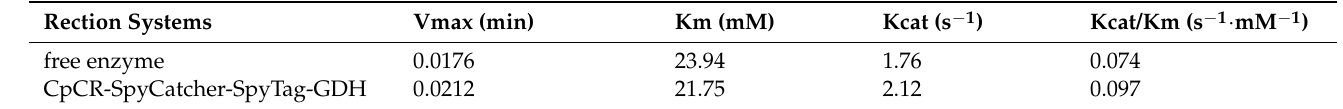
Table 8. Kinetic parameters of the free enzyme and CpCR-SpyCatcher-SpyTag-GDH.